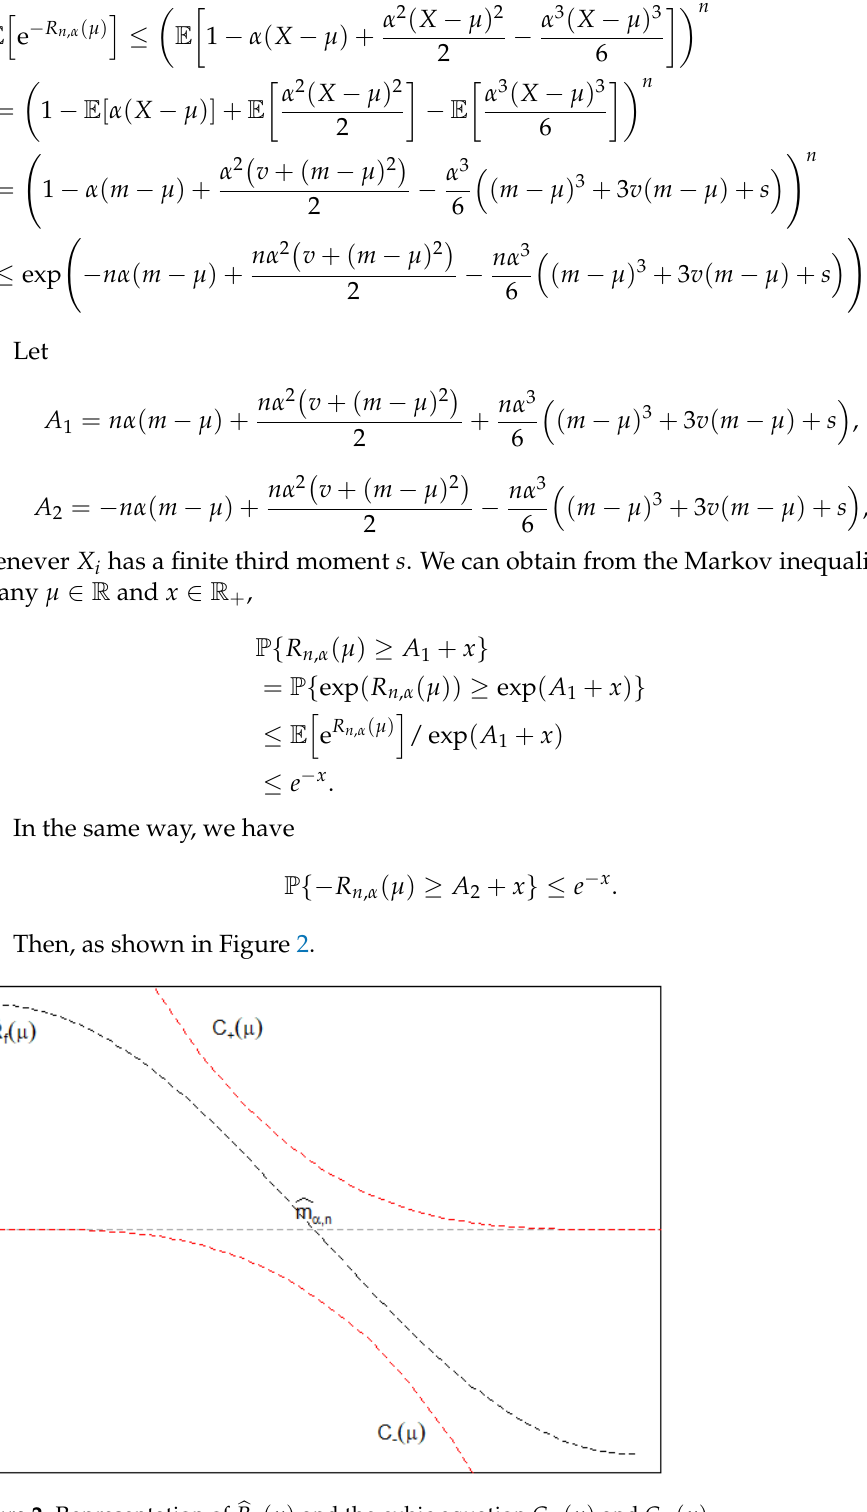
Figure 2. Representation of (cid:98) R f ( µ ) and the cubic equation C + ( µ ) and C − ( µ )